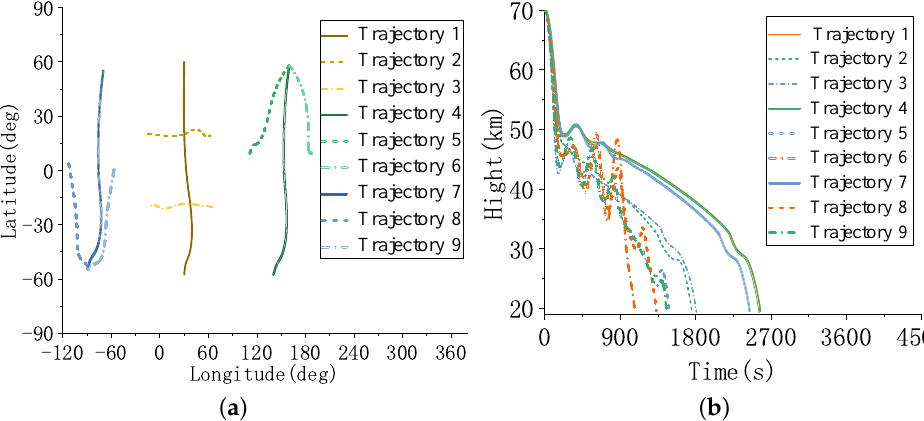
Figure 10. The trajectories of HGVs. ( a ) The latitude and longitude of the trajectories. ( b ) The altitude of the